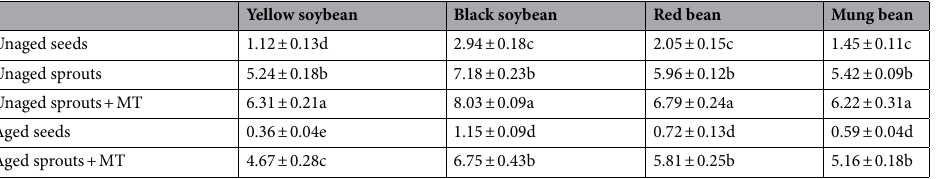
Table 1. Total phenolics contents. The total phenolics content (mg gallic acid g −1 dry weight) was measured in control and aged bean seeds and sprouts germinated from melatonin-treated aged seeds. Means within each column (n = 3) followed by the same letter are not significantly different ( p < 0.05). “(un)aged sprout” refers to the germinated seed and sprout from an (un)aged seed. MT melatonin.